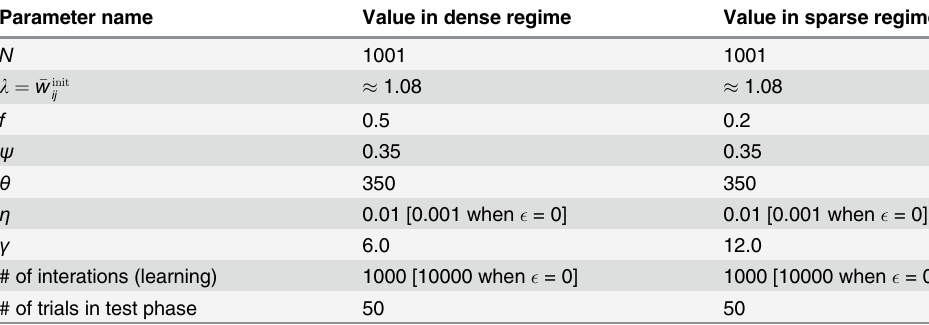
Table 1. Table of parameters in the